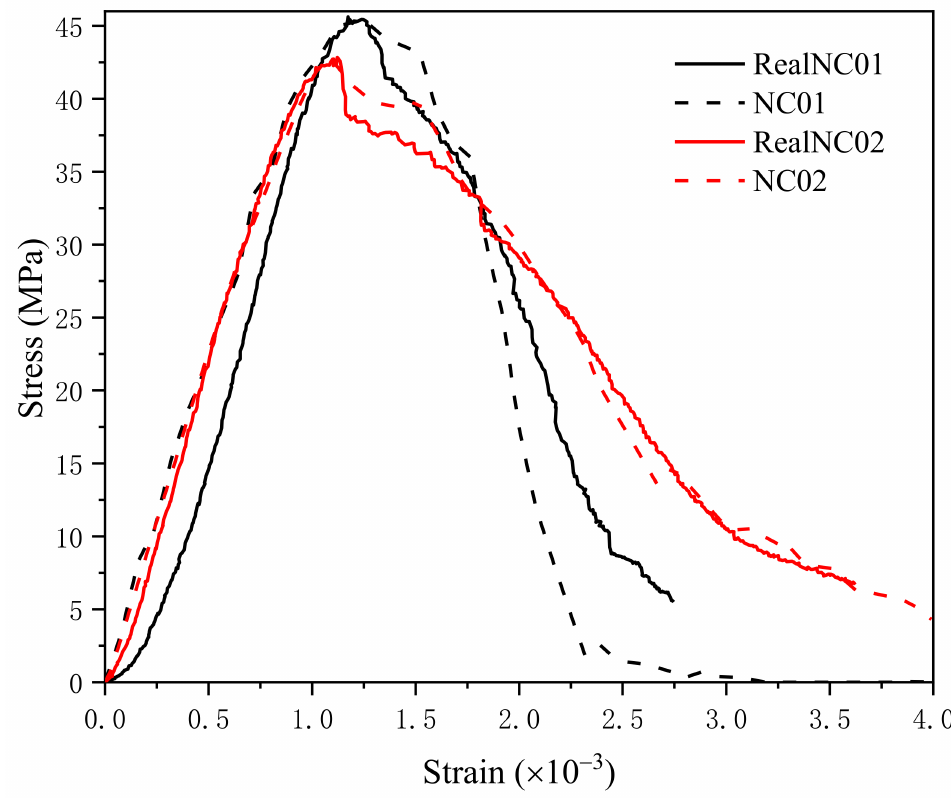
Figure 11. Stress − strain curves of experiment and